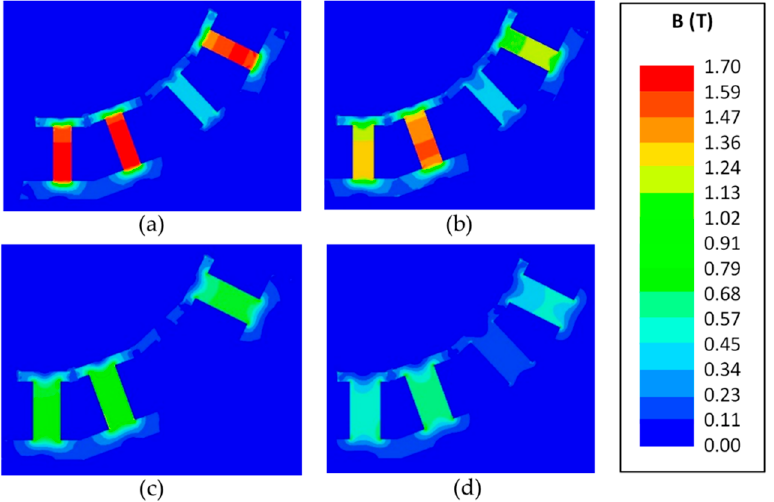
Figure 3. FEA simulation results showing magnetic flux density in adjacent stator stems, simultaneously excited (300 A-t), as functions of stem diameter: ( a ) d = 10 mm, ( b ) d = 12 mm, ( c ) d = 14 mm, ( d ) d = 16 mm.